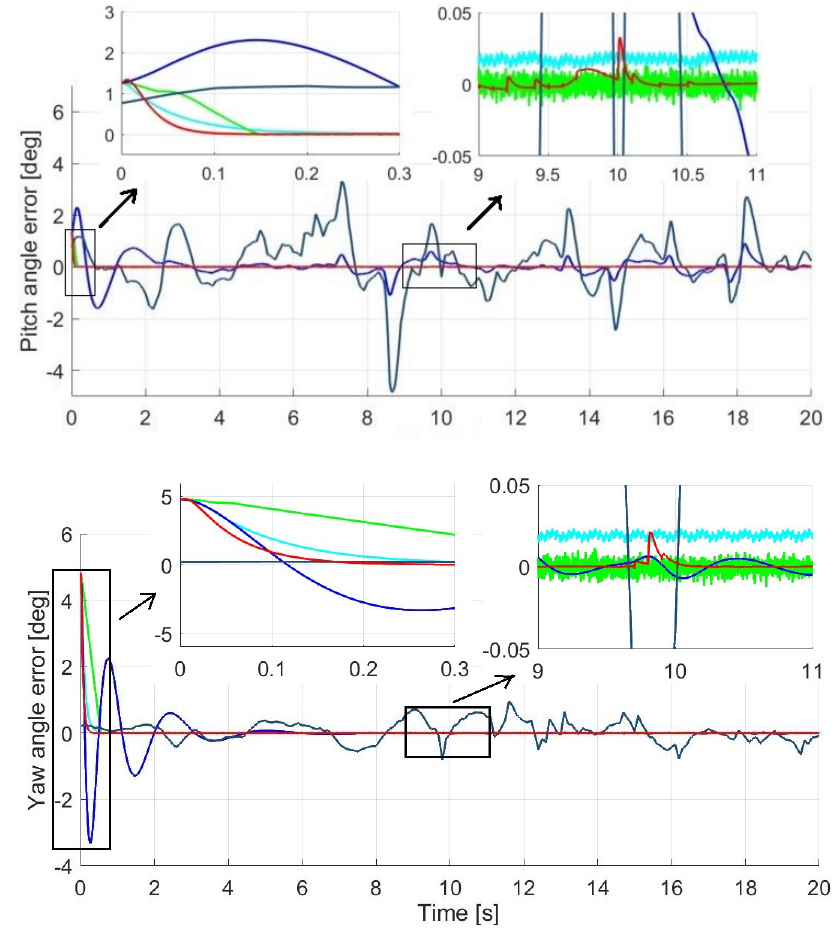
Figure 13. Tracking performance with real-time data. From the real-time experiments, the recorded control efforts are shown in Figure 14, where the steady-state yaw torque is a constant as the quadcopter was controlled to lift up with a linearly increasing height while performing a circular trajectory during the test.